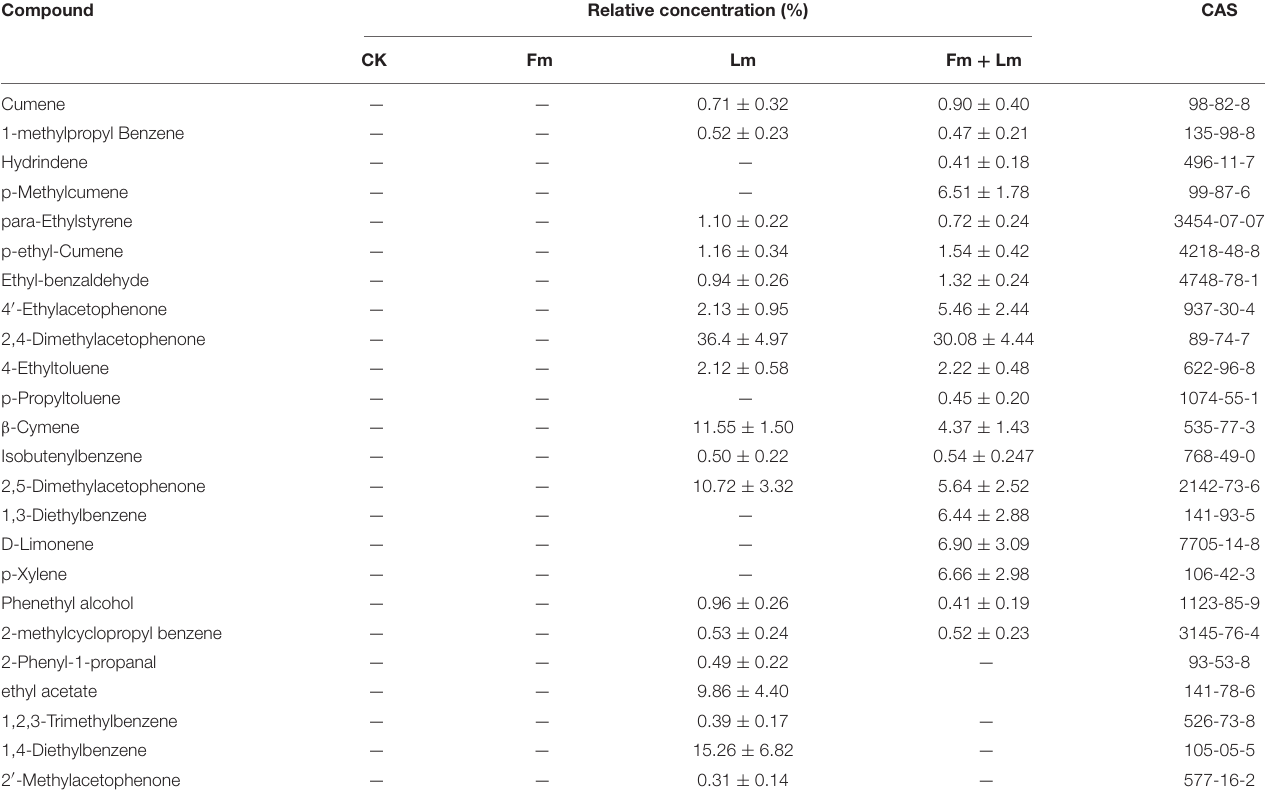
TABLE 2 | The composition and concentration of volatile organic compounds (VOCs) collected from plants through GC-MS analysis, included four treatments. Compound Relative concentration (%)